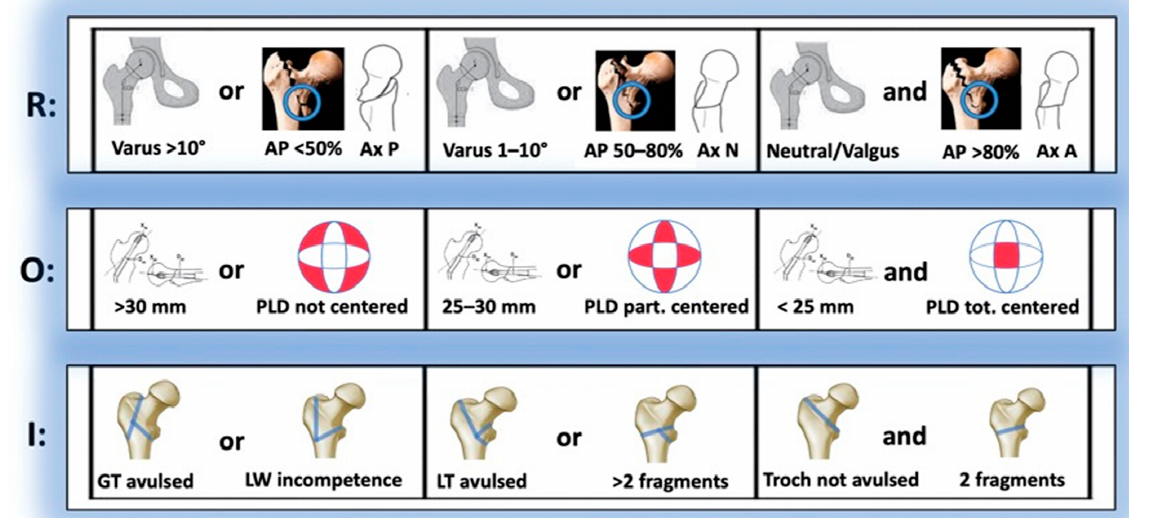
Figure 3. GammaTScore algorithm obtention chart.